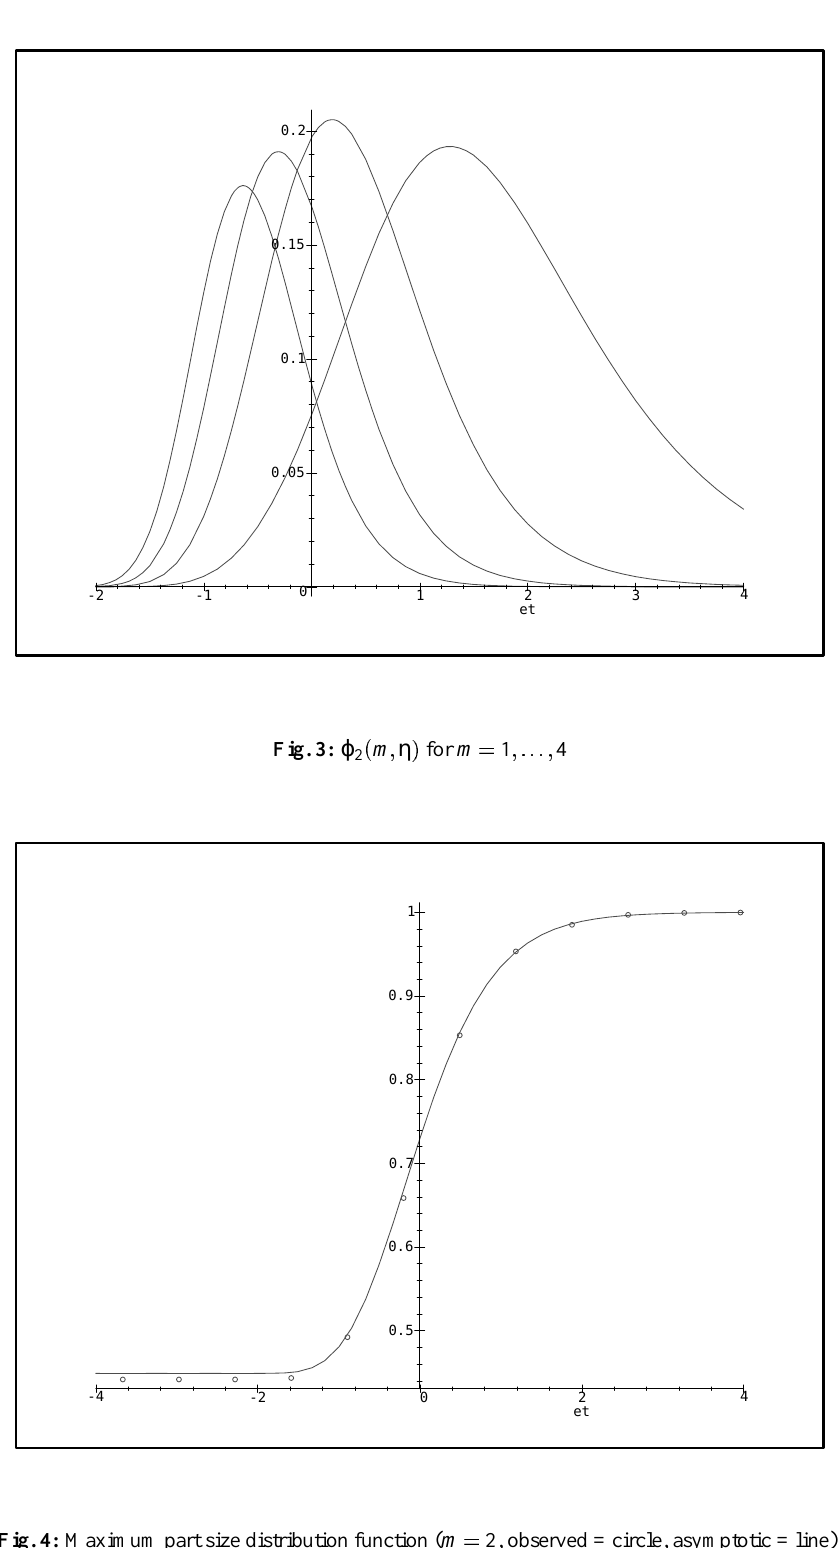
Fig. 4: Maximum part size distribution function ( m